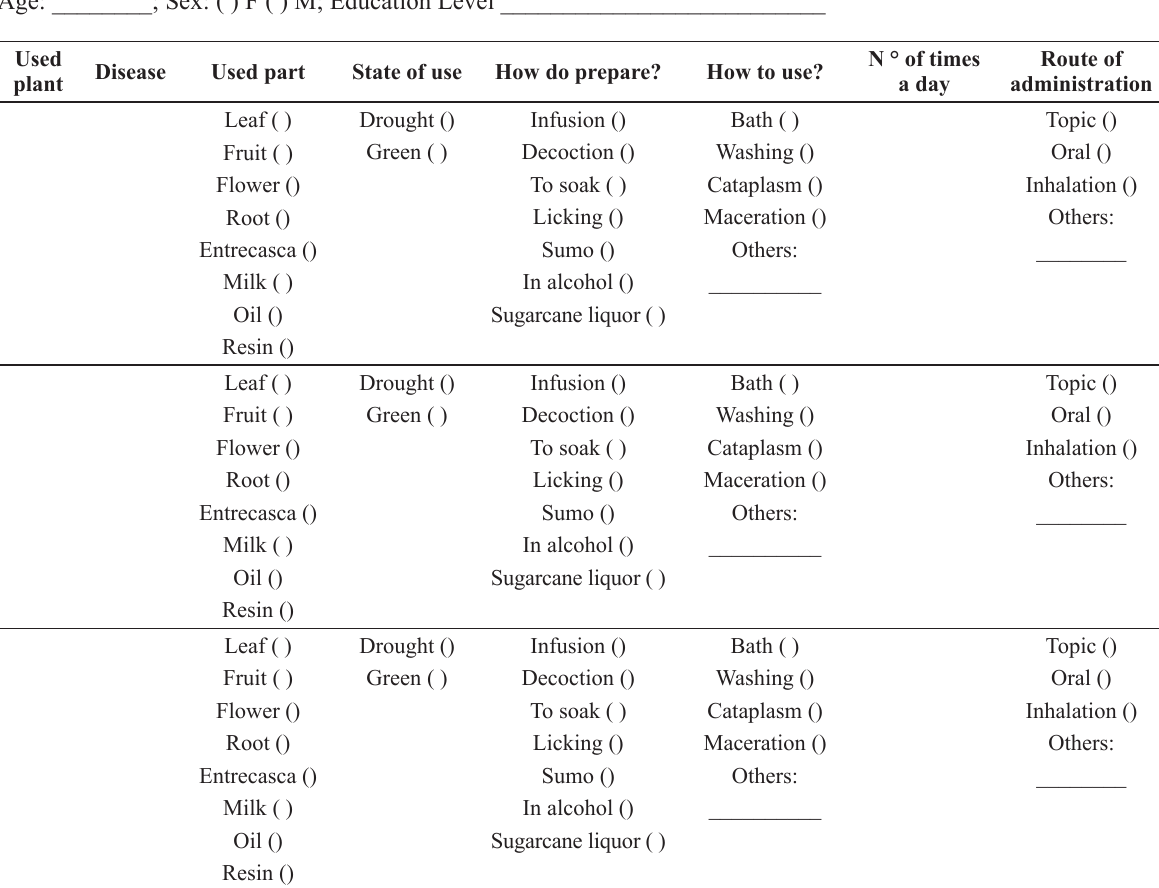
Table SI - List of native medicinal species indicated by the interviewees of the Angico de Cima community in the city of Aurora, Ceará, Brazil. Table SII - Informant consensus factor based on the citations of use of the native medicinal species indicated by the community informants Angico de Cima in the city of Aurora, Ceará,